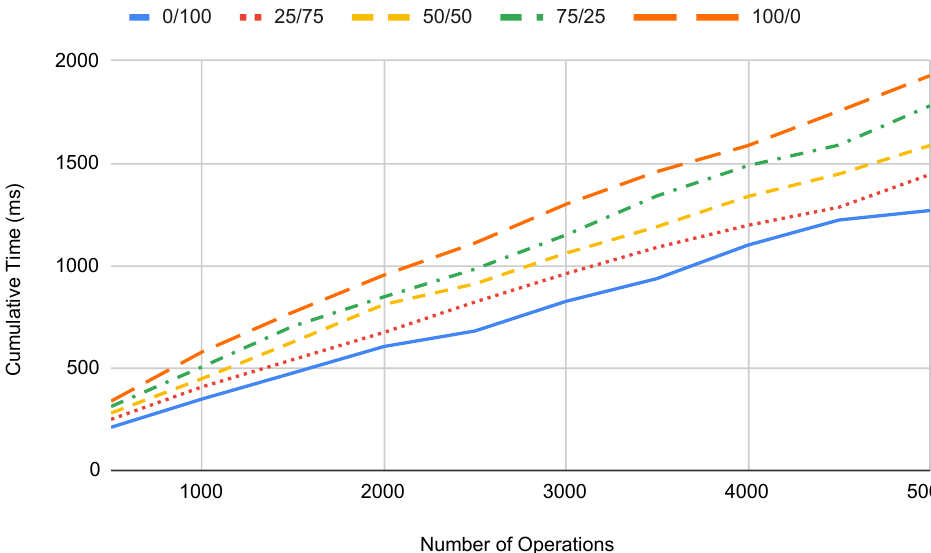
Figure 14. Cumulative Time taken for Consistency